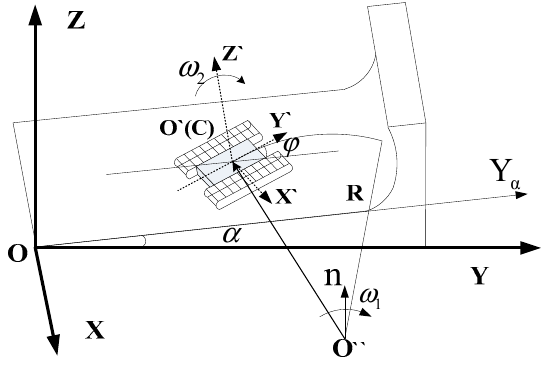
Figure 2. Roadheader steering diagram on an inclined